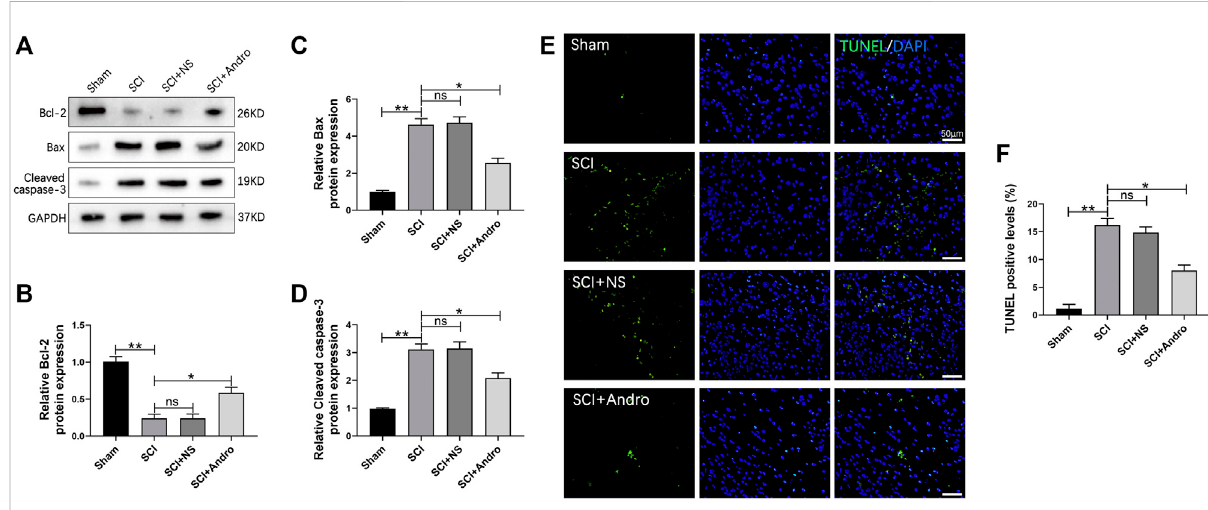
FIGURE 2 Andro treatment reduced neuronal apoptosis after SCI. (A) Western blot analysis showing the expression levels of apoptosis related proteins (Bcl-2, Bax and Cleaved caspase-3). (B – D) Quanti fi cation of relativeBcl-2, Baxand Cleaved caspase-3 proteinlevels. (E) TUNEL stainingof neuronal apoptosis at 28 days after Andro treatment. (F) Quantitative estimation of the number of TUNEL positive cells. Data are presented as the mean ± SD, n = 3 per group.* p < 0.05,** p < 0.01, ns p ＞